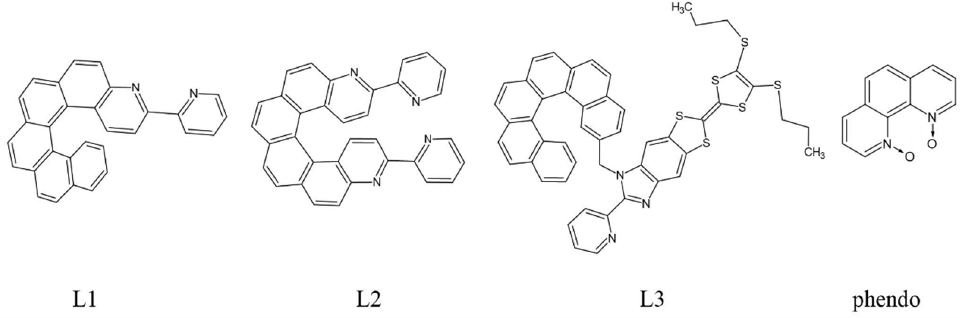
Figure 1. Helicenes used as ligands in the lanthanide-based complexes reported to date: L1 = 3-(2-